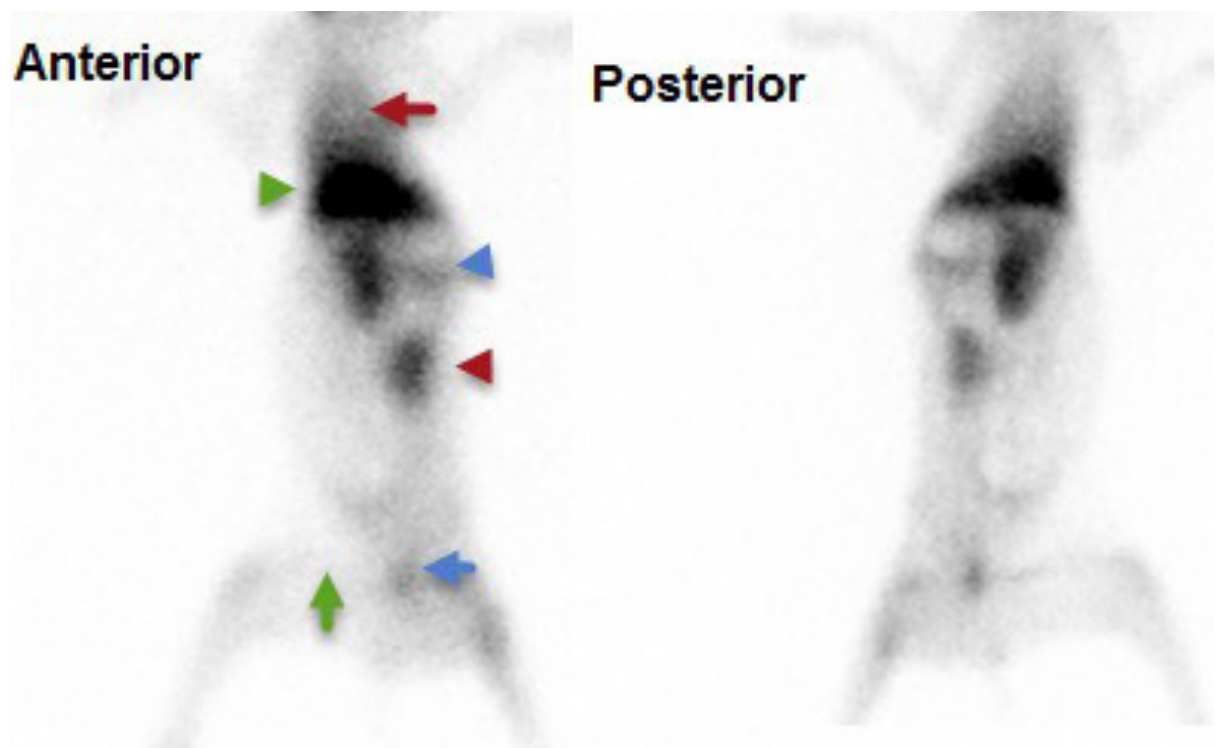
FIGURE 2 - Typical anterior and posterior images of a rabbit imaged 90 minutes after the injection of 66.6 MBq of 99m Tc- HMPAO-labeled platelets. The red, blue, and green arrowheads and red, blue, and green arrows indicate the left kidney, spleen, liver, lung, heart, bladder, and right iliac artery,